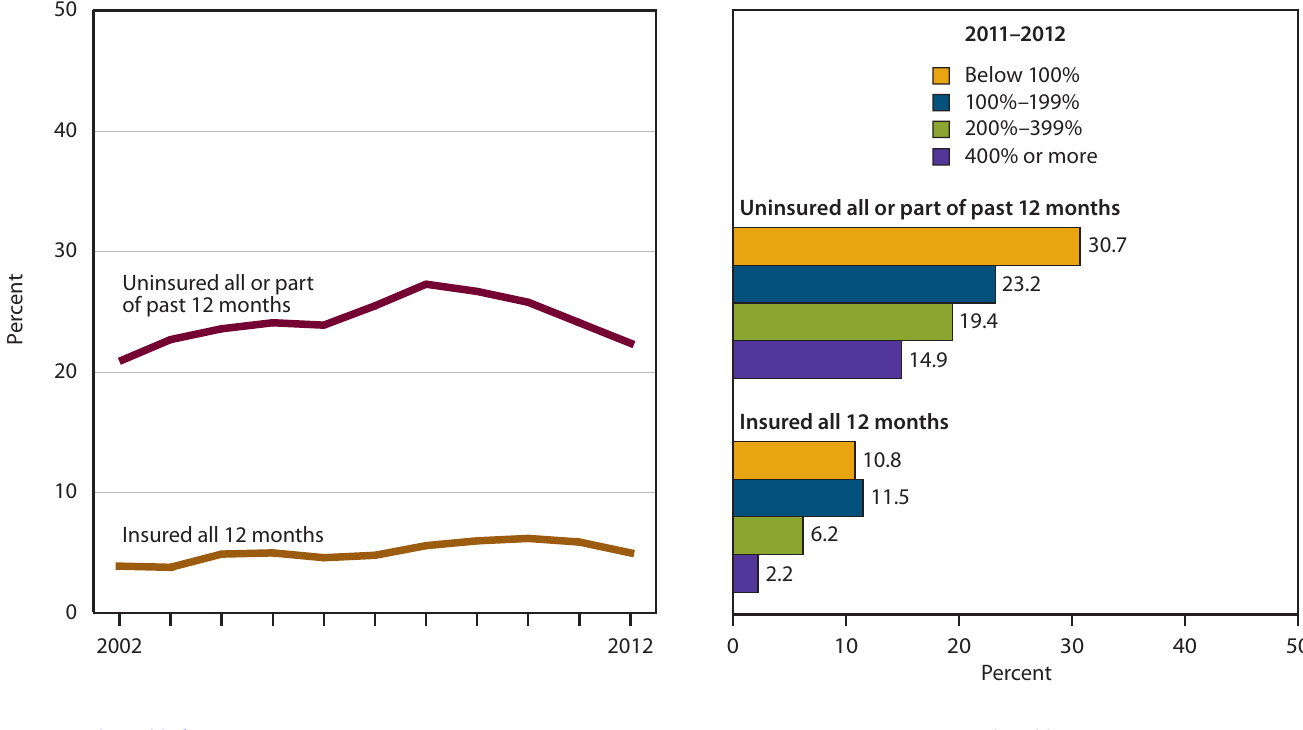
Figure 23. Nonreceipt of needed prescription drugs in the past 12 months due to cost among adults aged 18–64,